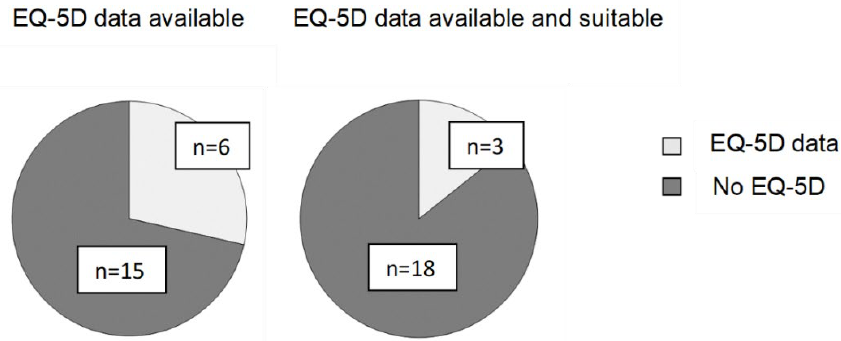
Figure 2. A (EQ-5D data available)+ B (EQ-5D data available and suitable): EQ-5D collected in clinical trials or observational studies in the evaluation of previously assessed highly specialised technologies at the National Institute for Health and Care Excellence in England (Table S2).